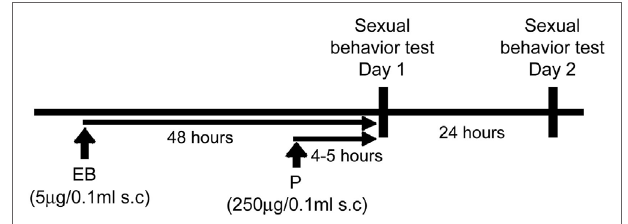
FigUre 1 | Experimental paradigm.